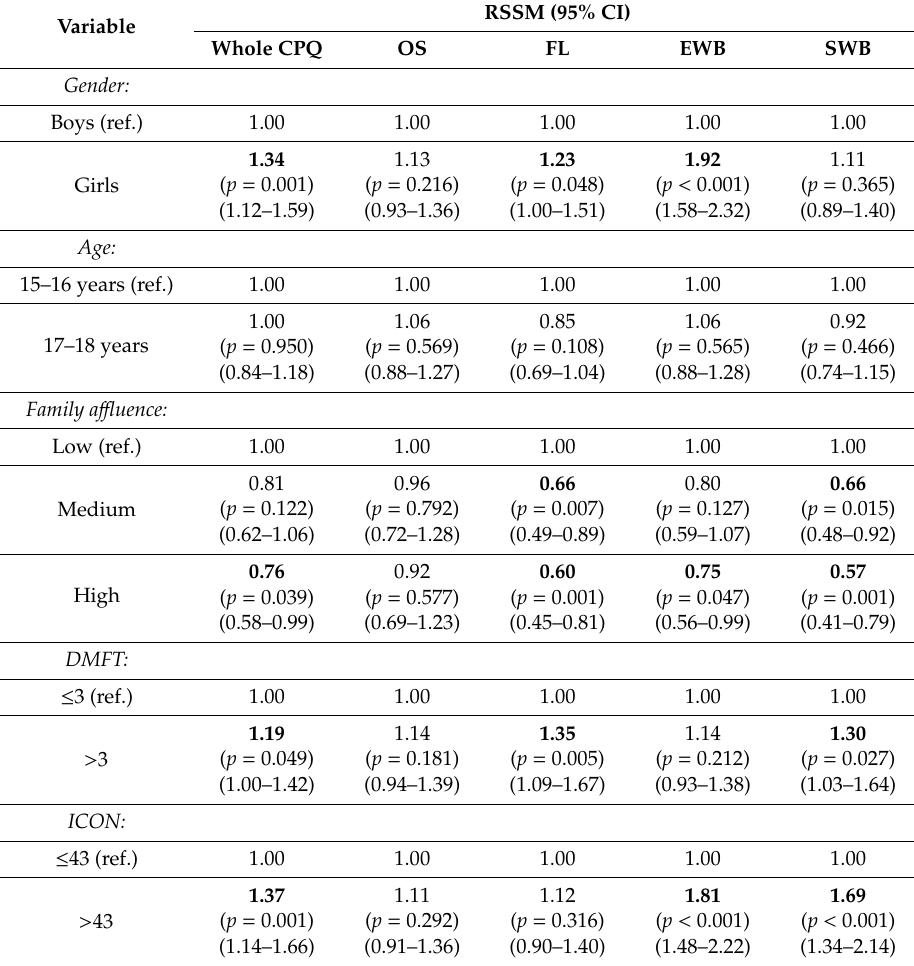
Table 3. Relationship between the clinical characteristics of oral health and CPQ sum scores: results of the multivariate NBR analysis adjusting data for gender, age, and family a ffl uence ( N =